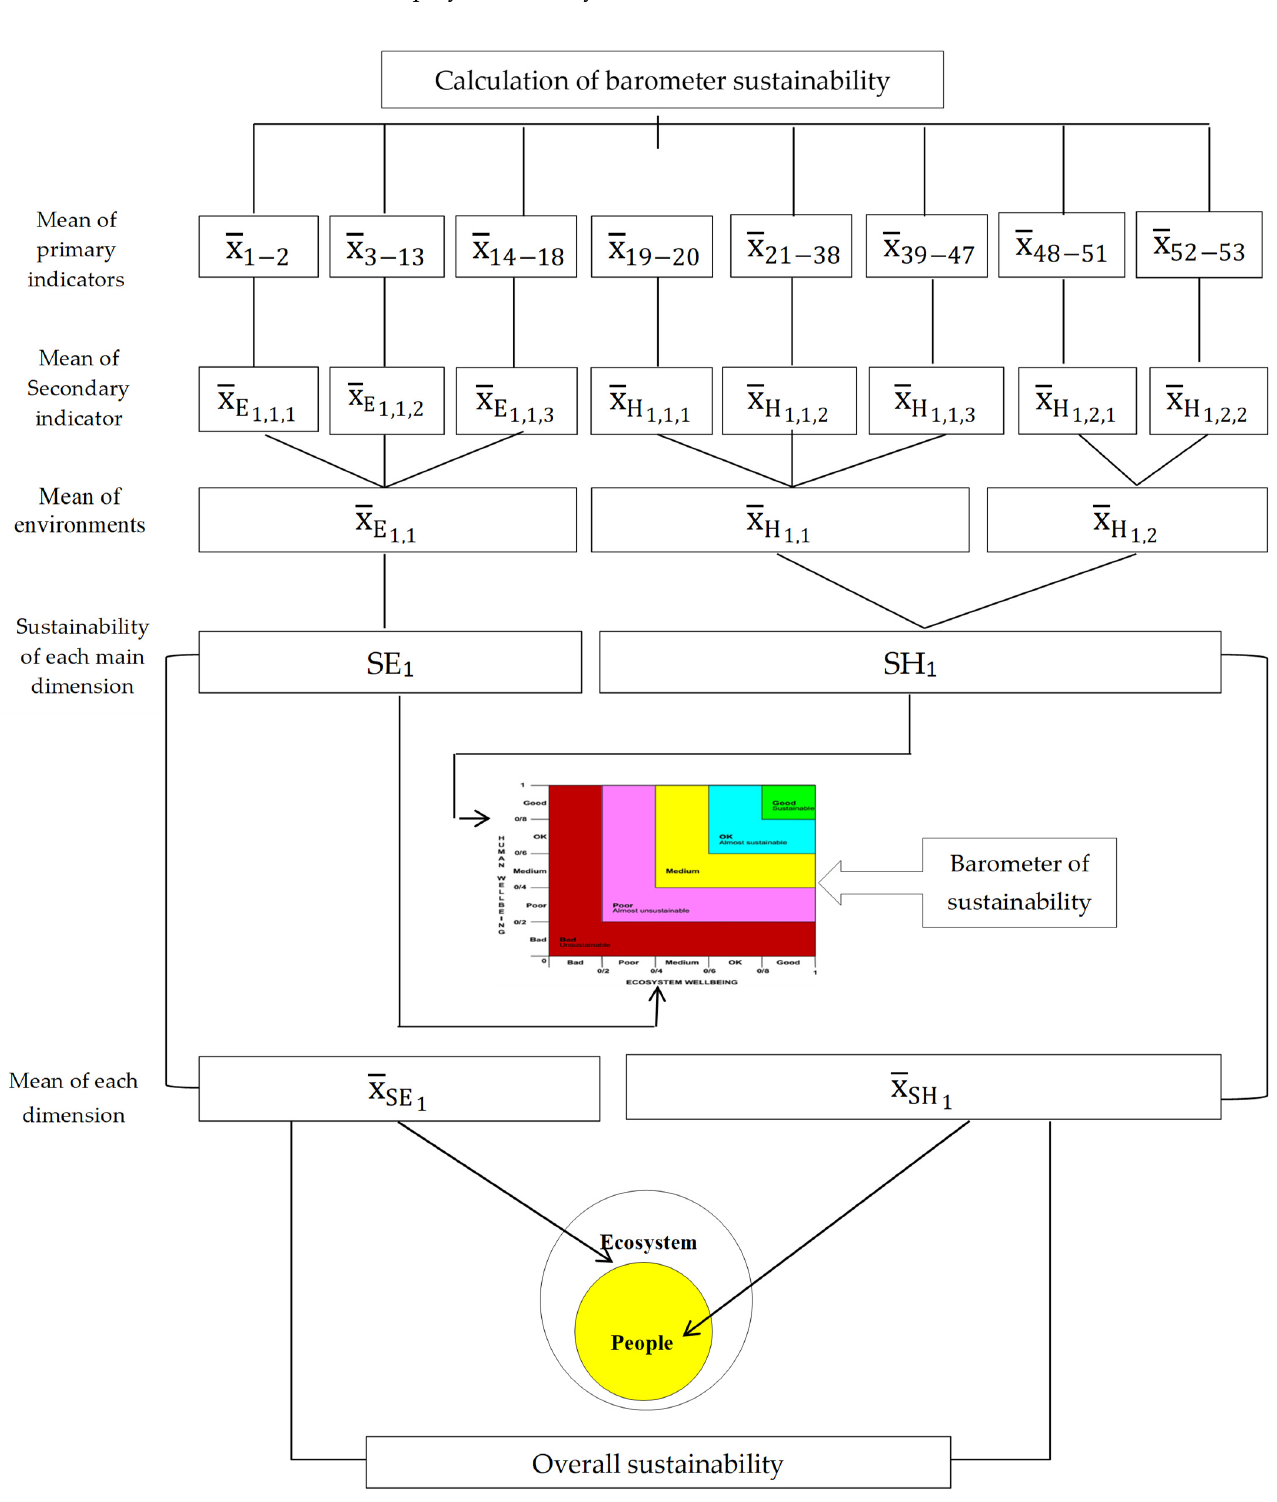
Figure 7. Hierarchical framework for the process of barometer of s ustainability. Table 4. Sustainability classification from Prescott-Allen’s perspective 1997.